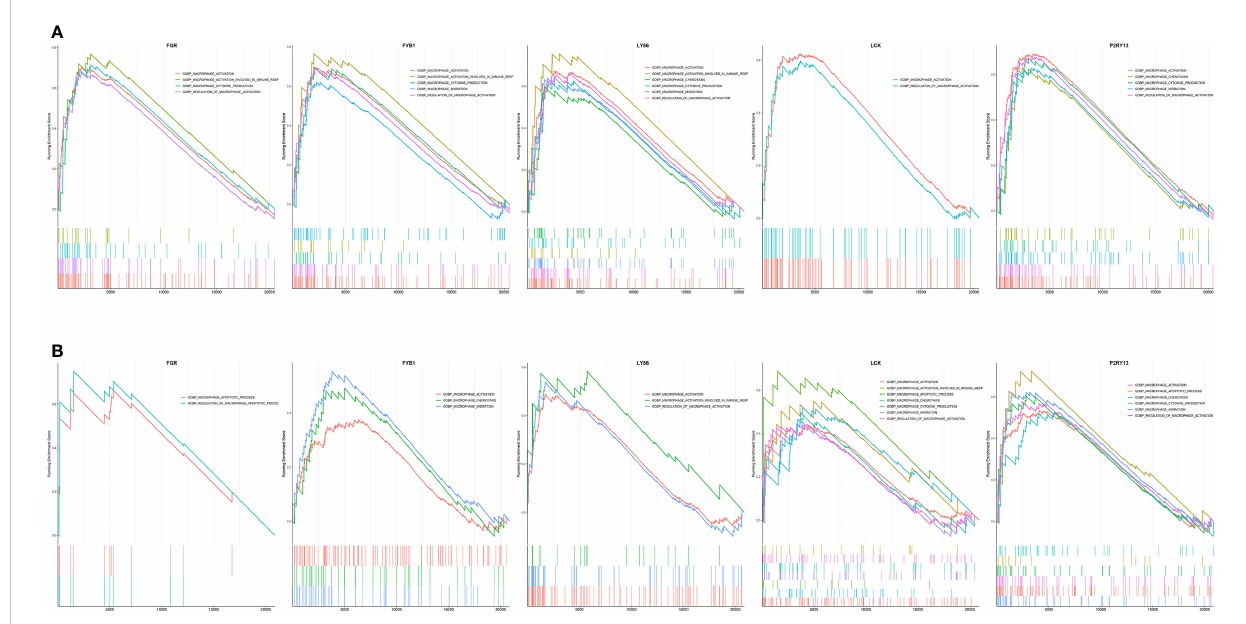
FIGURE 8 Merged enrichment plot of FGR , FYB1 , LY86 , LCK and P2RY13 from gene set enrichment analysis of GSE152991 (A) and GSE16134 (B) datasets. The threshold value of GSEA results was set as |NES| >1.0, p -value<0.05 & FDR p -value<0.25. GSEA, gene set enrichment analysis; NES, normalized enrichment score; FDR, false positive